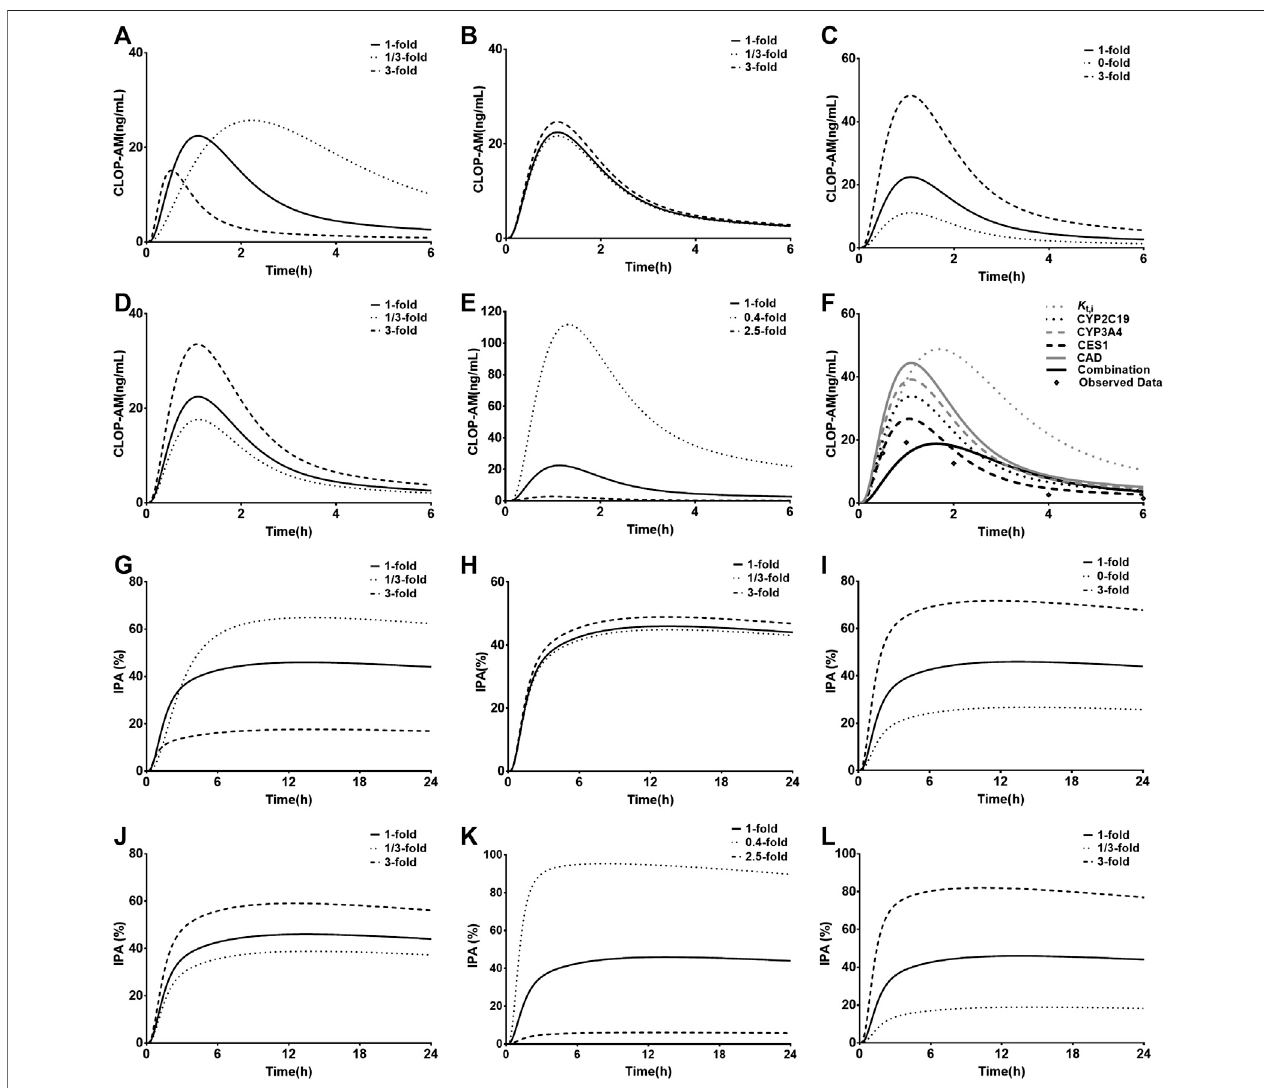
FIGURE 7 | Results of sensitivity analysis. The effects of variations in K t,i (A) , V max,CYP2C9 (B) , V max,CYP2C19 (C) , V max,CYP3A4 (D) and CL int,CES1 (E) on pharmacokinetic pro fi les of CLOP following oral 300 mg of CLOP to healthy individuals; (F) the individual contributions of alterations in V max,CYP2C19 , V max,CYP3A4 , CL int,CES1 and K t,i to pharmacokineticsofCLOP-AMandtheirintegrationsfollowingoral600 mgofCLOPtoCADpatientswithDM.Theeffectsofvariationsin K t,i (G) ,activitiesof V max,CYP2C9 (H) , V max,CYP2C19 (I) , V max,CYP3A4 (J) , CL int,CES1 (K) and k irre (L) on IPA(%) of CLOP-AM following oral dose of 300 mg CLOP to healthy individuals.